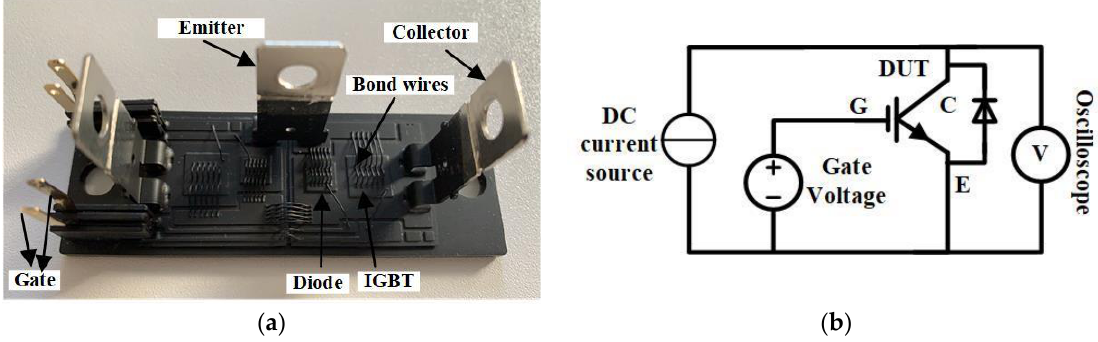
Figure 11. ( a ) Open package IGBT module, black-painted ( b ) Main electrical